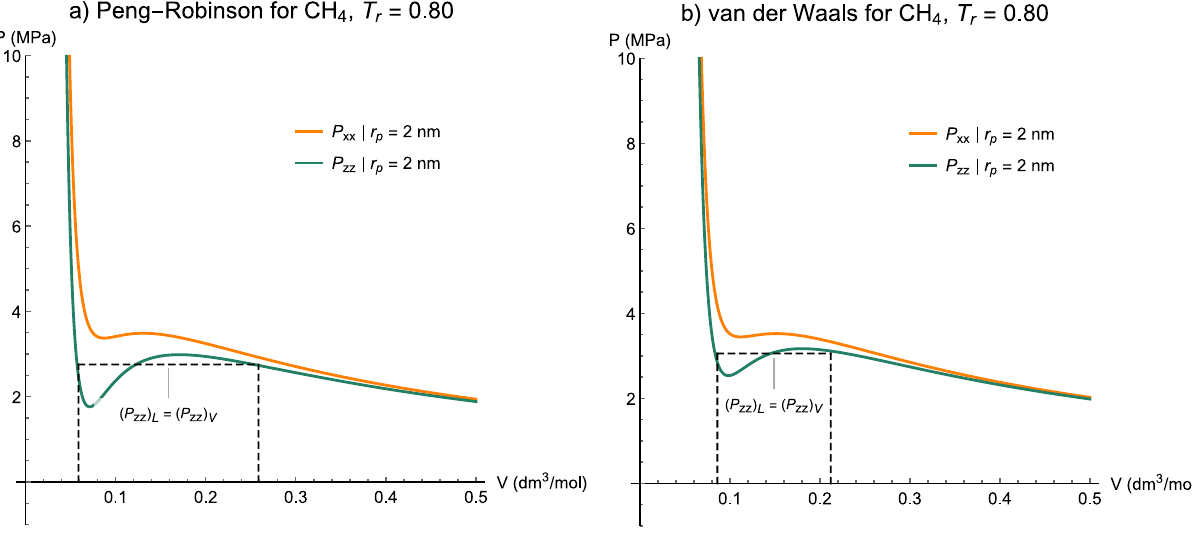
Figure 14. Capillary condensation of axial pressure and the tendency of the transverse pressure to construct the 0.80 obtained from ( a ) Peng-Robinson and ( b ) van der Waals equations two-phase region for methane at T r = of state associated with the Kihara potential function. Dashed line evidence the Maxwell construction for two- phase